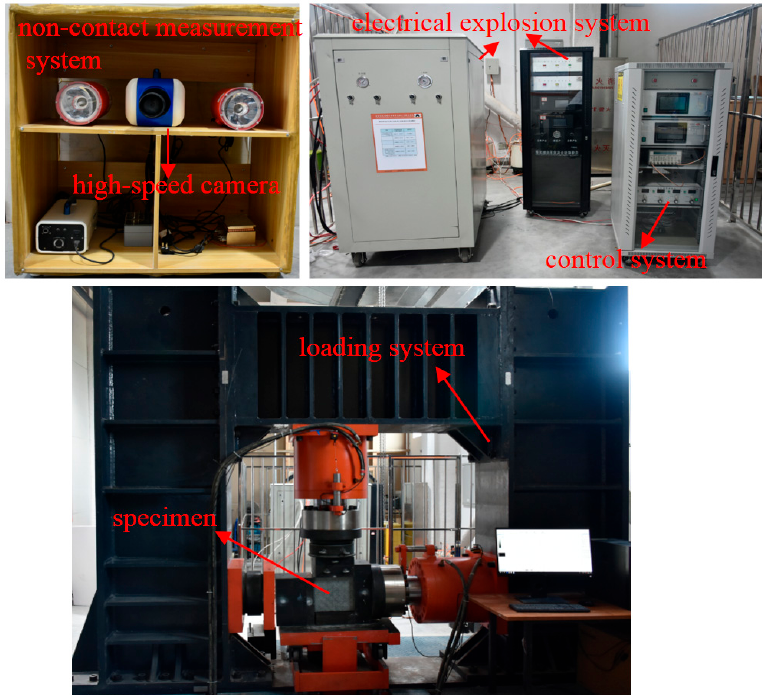
Figure 1. Photo of the testing apparatus. Table 1. DIC hardware parameters.